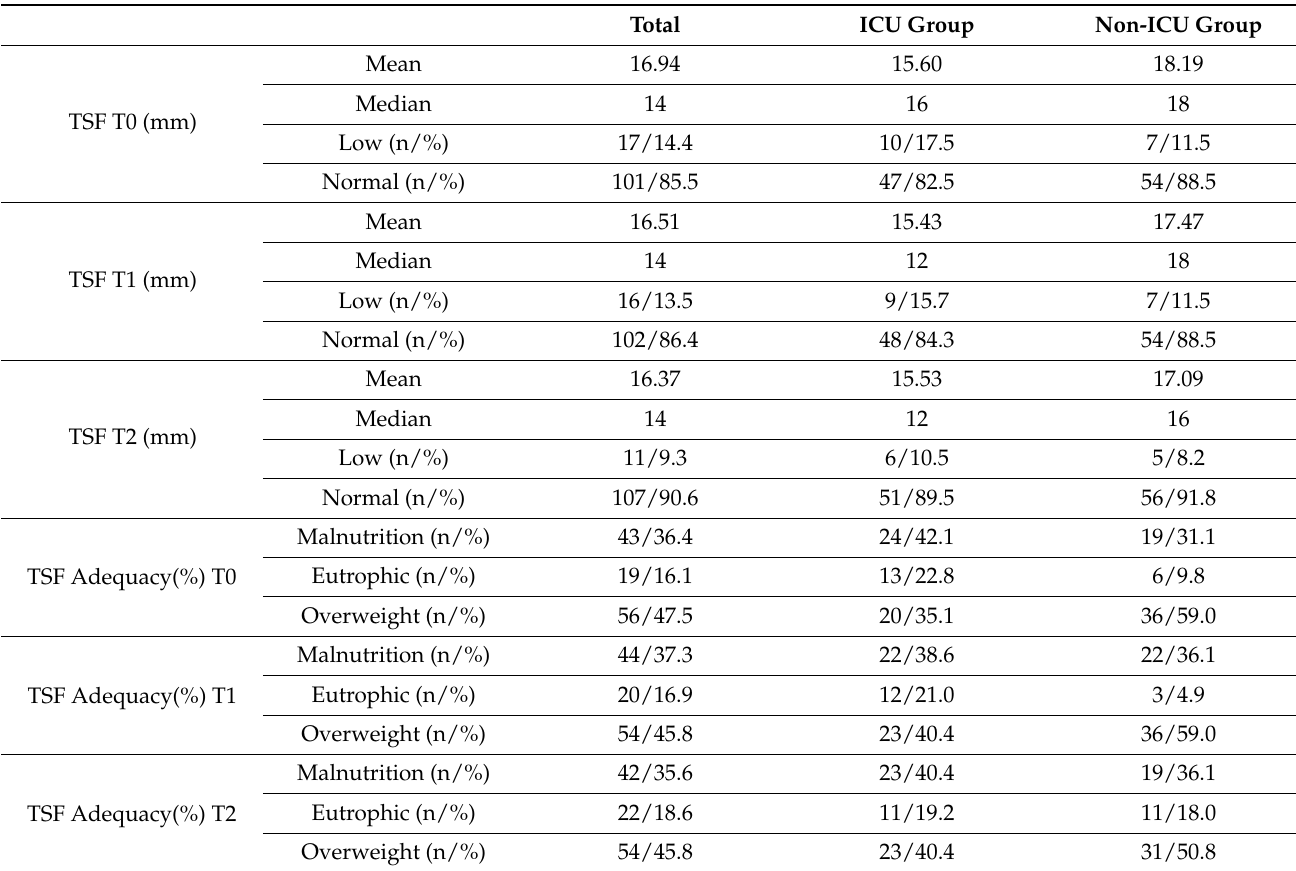
Table 3. Characterization of subjects and respective results from Tricipital Skinfold (TSF) and Tricipital